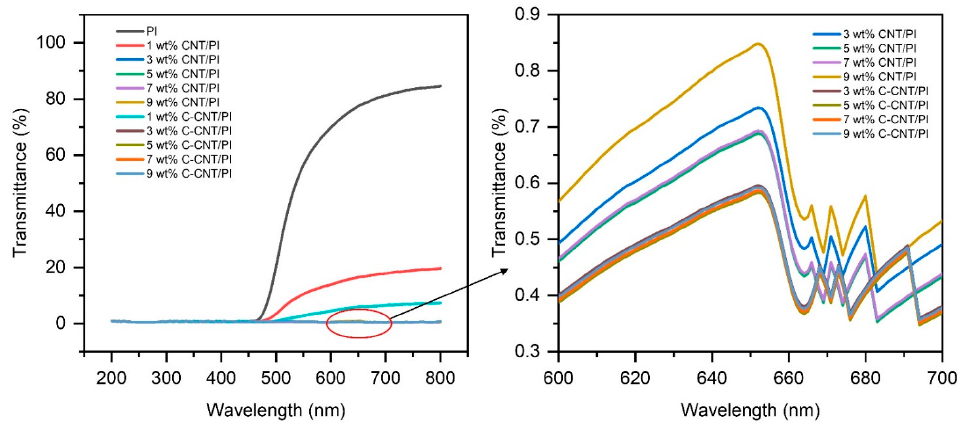
Figure 8. UV–visible spectra of PI, CNT/PI and C-CNT/PI films. In order to study the dispersion and morphology of CNT and C-CNT in the films, the cross-sections of CNT/PI and C-CNT/PI films with filler contents of 0, 1, 3, 5, 7, and 9 wt.% were observed by SEM (Figure S1). The cross-sections were the fracture surfaces of the broken films after the mechanical properties test. As shown in Figure 9, CNT and C-CNT are marked with red circles. When the film is stretched, the strong adhesive interaction between carbon nanotubes and polymer matrix will produce stress, leading to local plastic deformation and rough fracture surface [47]. The C-CNT was mainly broken near the surface of the PI matrix, and compared with CNT/PI film, C-CNT/PI film had less filler exposed outside the matrix and a shorter filler length. This phenomenon means that the interfacial adhesion between C-CNT and PI matrix was better than CNT, which made C-CNT harder to be pulled out when the film broke [54]. Because of the hydrogen bonds formed by the H atom of the –COOH group on the surface of C-CNT and the C=O bond of the PI molecule, C-CNT was less agglomerated than CNT. As a result, C-CNT can be well wetted by the PI matrix, so the interfacial adhesion between C-CNT and PI matrix was better than CNT. In brief, C-CNT had better dispersion and less aggregation than CNT in the film, so it had better interaction with the PI matrix.